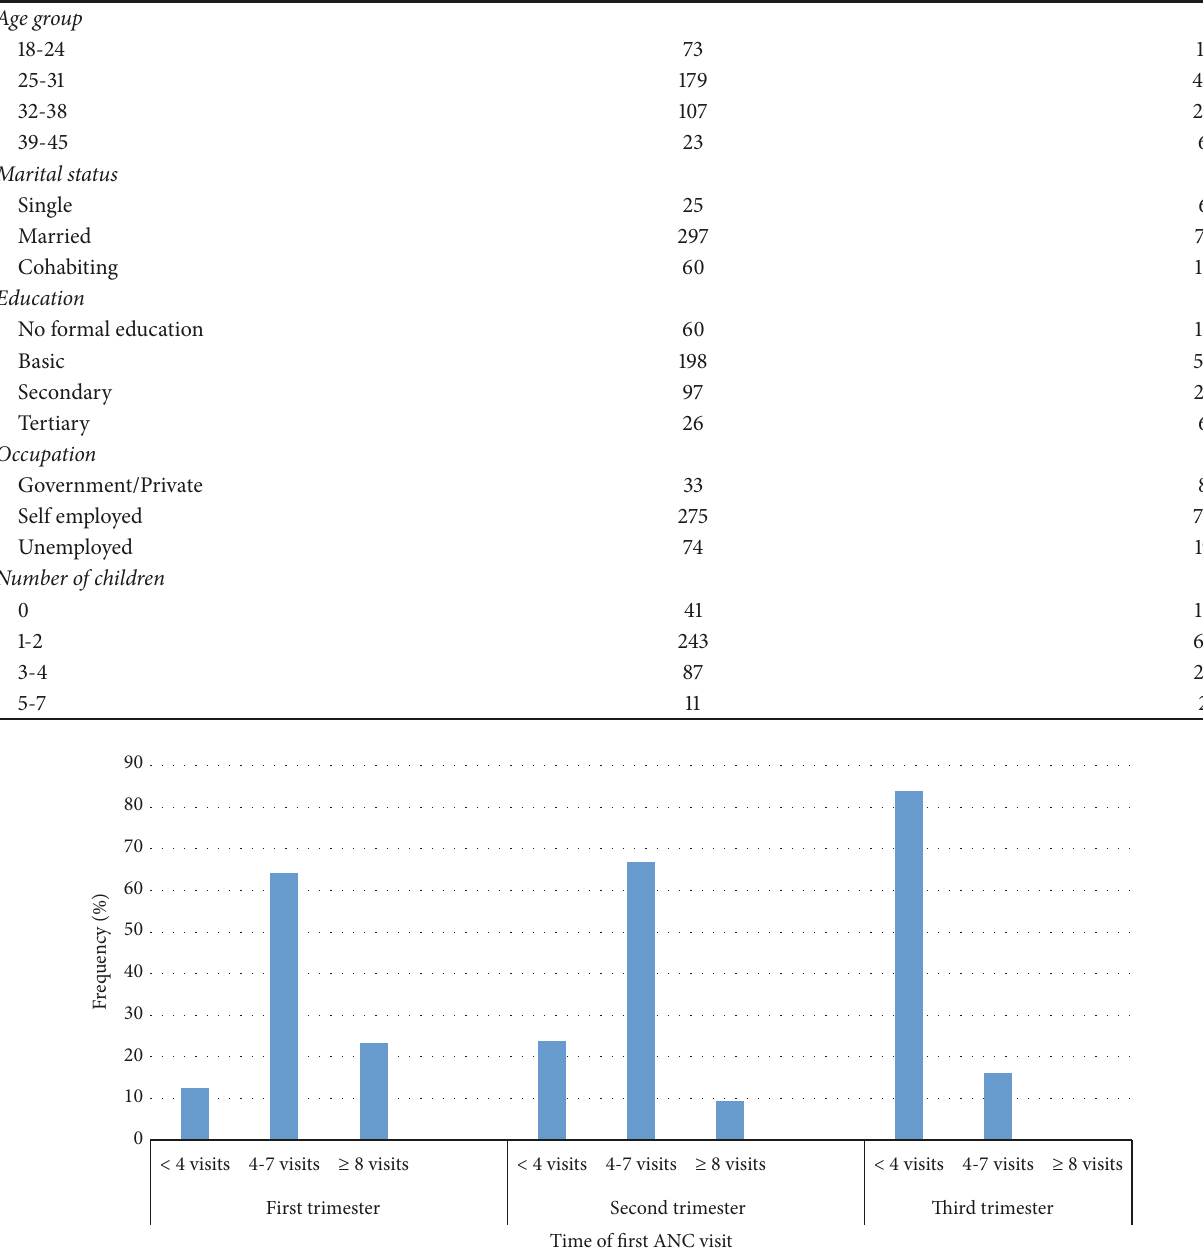
Figure 1: Time of first ANC visit and total number of visits